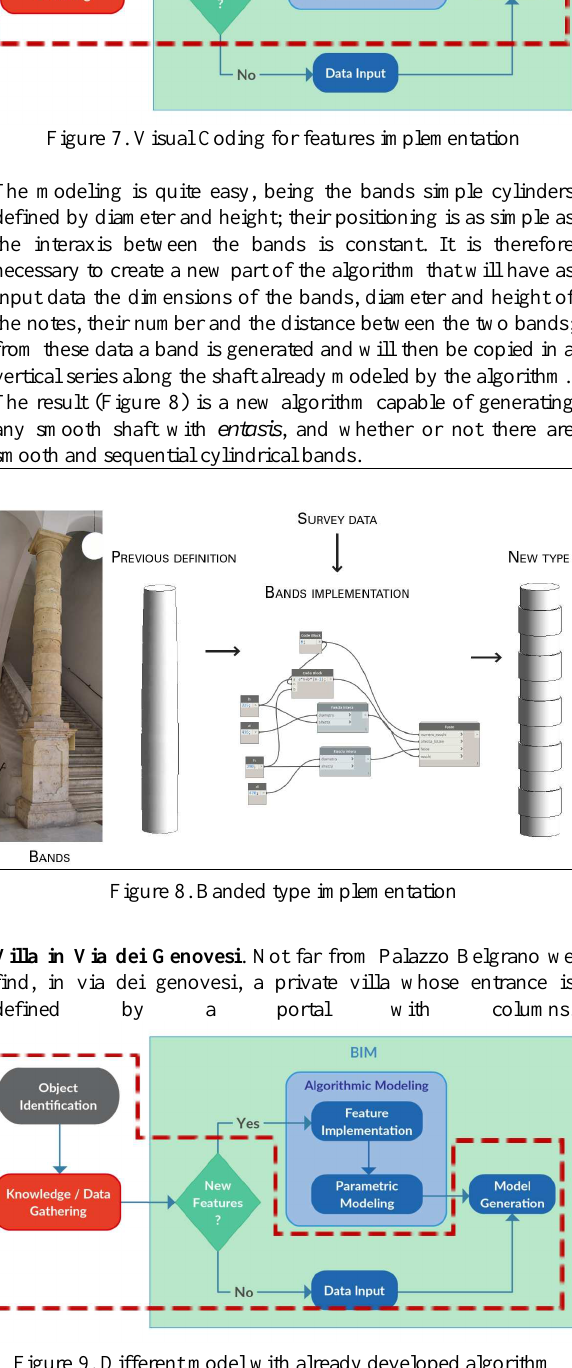
Figure 9. Different model with already developed